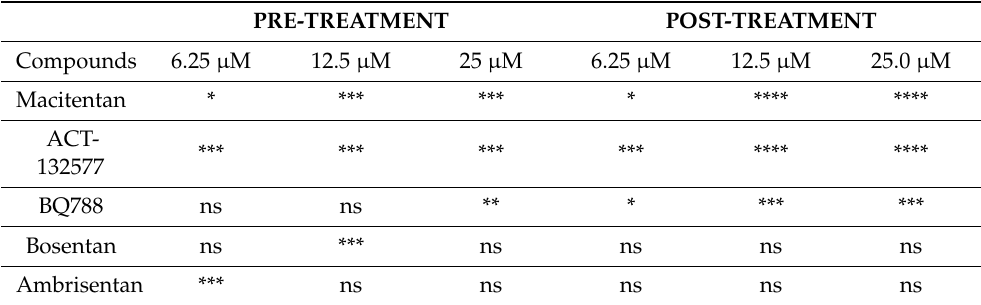
Table 2. Pre and post treatment of HCMV infected HUVECs with Ambrisentan, and ETAR- antago- nists at different concentrations.